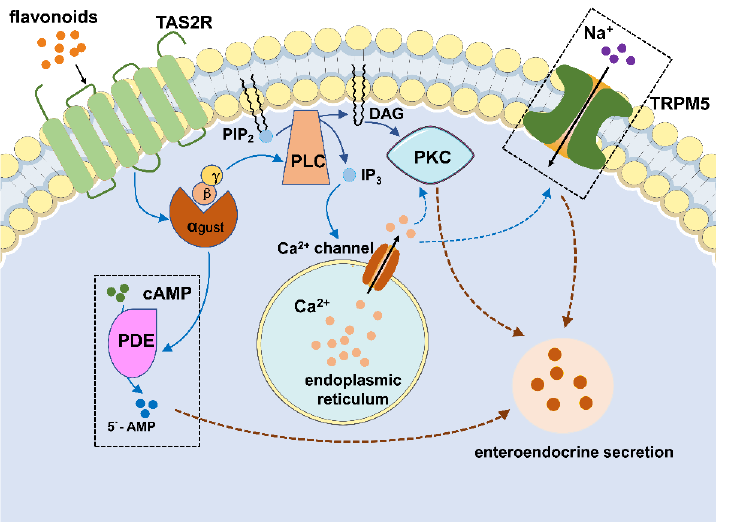
Figure 2. Potential pathways of enteroendocrine hormone secretion induced by flavonoids. The combination of ligands and TAS2R stimulates a signalling cascade, which comprises the G-protein gustducin detaching from the Gα and Gβγ subunits, activating phospholipase C β2 (PLCβ 2 ) and producing diacylglycerol (DAG) and inositol 1, 4, 5-trisphophate (IP 3 ), as well as opening transient receptor potential ion channel M5 (TRPM5), releasing intracellular Ca 2+ ([Ca 2+ ] i ), Na + influx, cellular depolarisation and the secretion of neurotransmitters. DAG and [Ca 2+ ] i also activate the protein kinase C (PKC) pathway. Additionally, the increased level of the intracellular Gα subunit triggers phosphodiesterase.